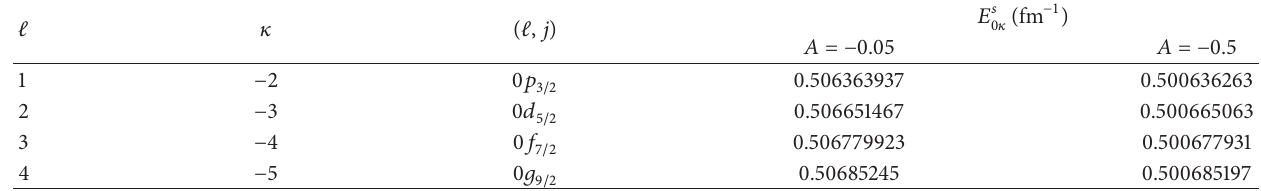
Table 2: Bound state for the spin symmetry 𝑎 𝑠 = 0.02 , 𝑏 𝑠 = 0.01 , 𝑀 = 0.5 fm −1 , and 𝐶 𝑠 = 1 fm −1 .